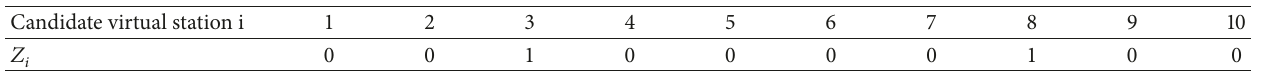
Table 2: Computation results of virtual station decision.